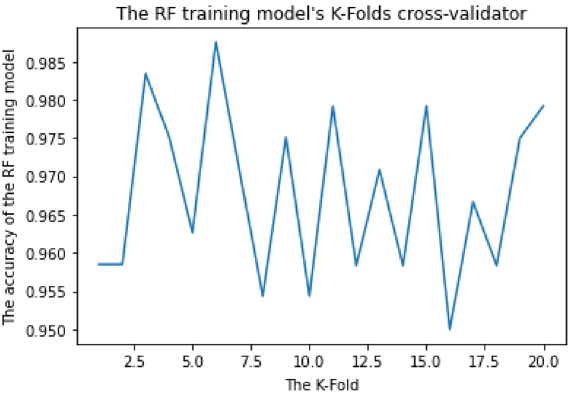
Figure 2. RF training model achieved 96.8% accuracy for multiclass classification.